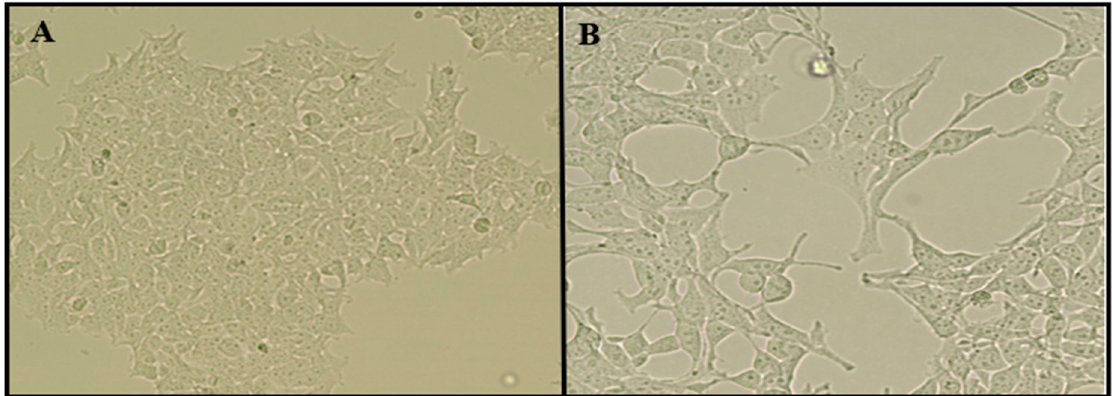
Figure 9. SHSY-5Y cells are differentiated into neuron-like cells by retinoic acid treatment: ( A ), negative control; and ( B ), 10 µM of all trans RA applications for 11 days. Table 2. Flow cytometry, cell cycle analyses of differentiated SHSY-5Y cell line into mature neuron cell